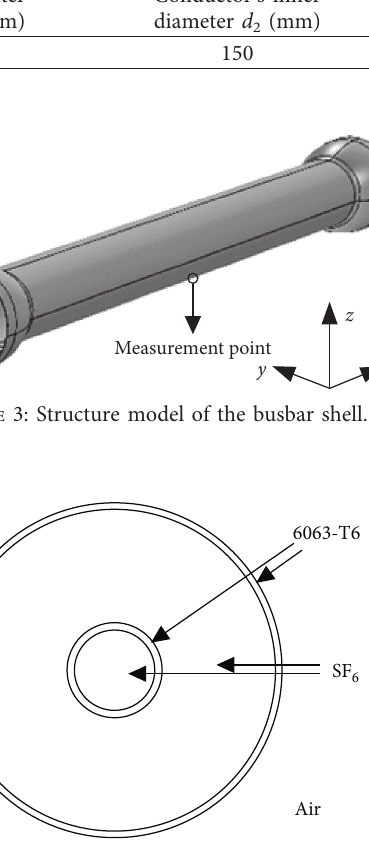
Figure 4: Two-dimensional busbar structure.